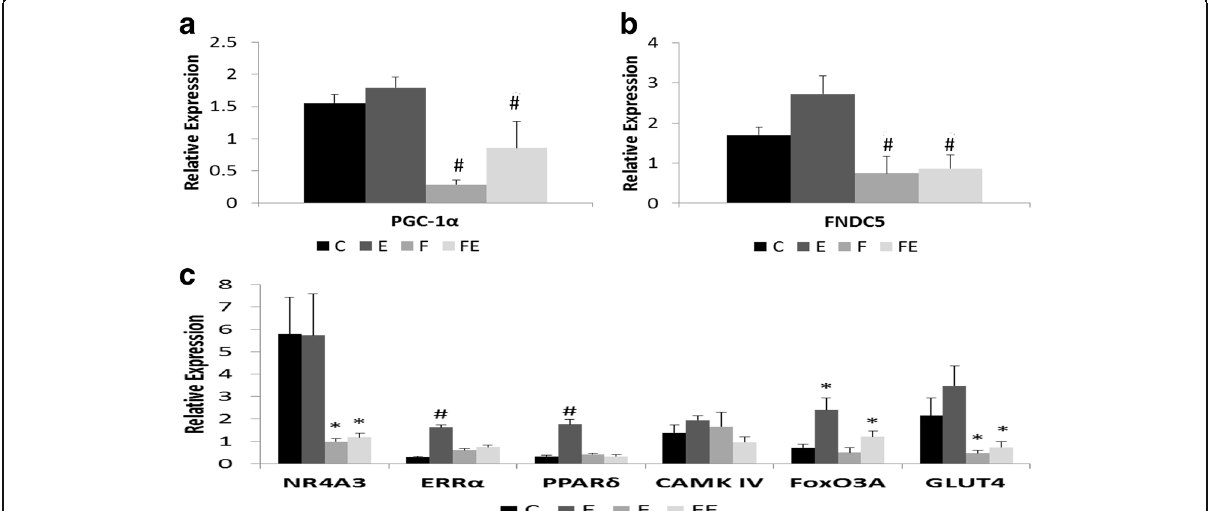
Fig. 2 Impact of aerobic training or fructose ingestion on expression of genes involved in regulation of mitochondrial biogenesis in rat skeletal muscle. a PGC-1 α 1. b FNDC5. c Transcriptional regulators of skeletal muscle adaptive response to exercise training and GLUT4. Groups: C control, E exercise, F fructose, FE fructose + exercise. Relative expression was calculated using methods described by Livak and Schmittgen. Results are presented as mean ± SEM. A main effect of fructose on expression of PGC-1 α 1, FNDC5, NR4A3/Nor-1, and GLUT4 was detected. In addition to